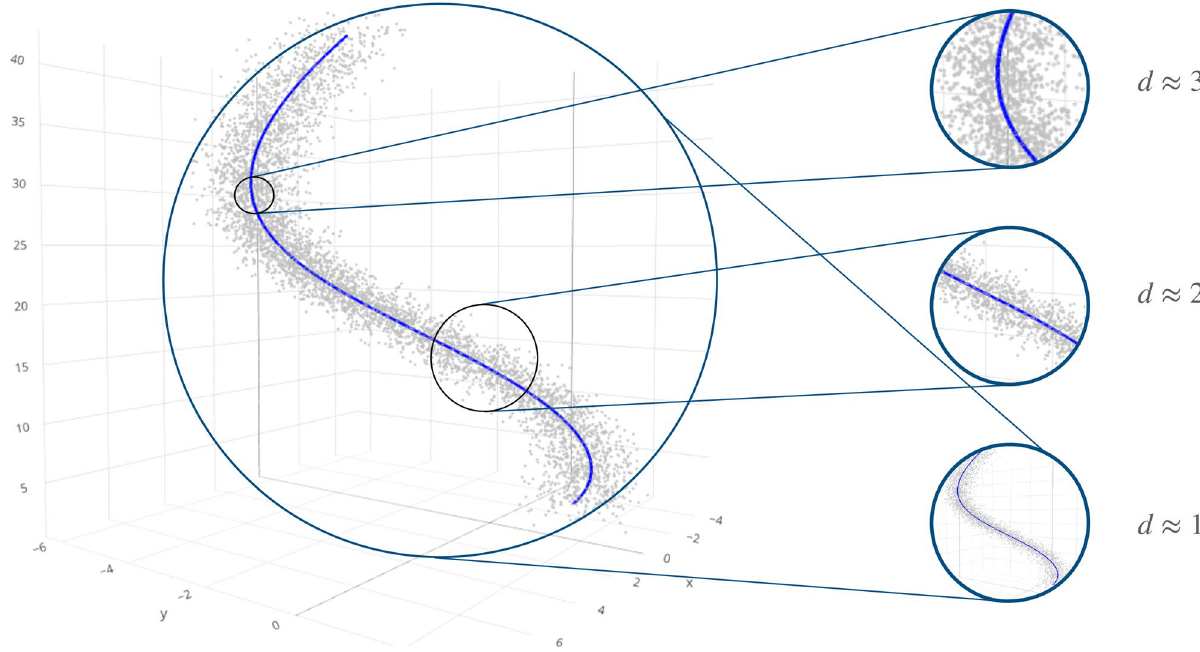
1 , σ 2 5000 , 0.5 , and σ 2 1 . The σ 2 S y = x = z = ¯ = =